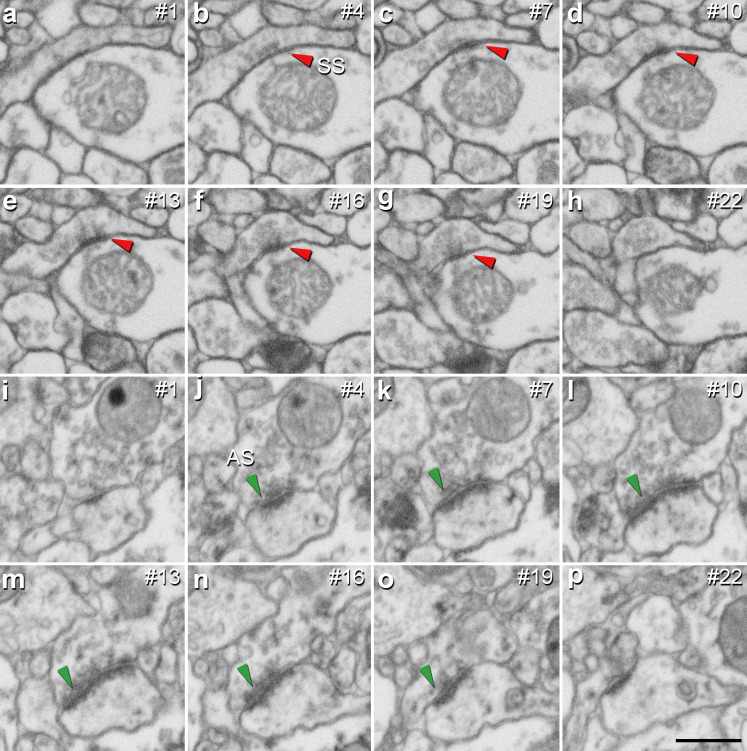
Identification of an asymmetric synapse (AS) and a symmetric synapse (SS) in the neuropil of the human CA1 region.(a−h) Crops from electron microscopy serial sections obtained by FIB/SEM to illustrate an SS (red arrowhead). (i−p) Crops from electron microscopy images following an AS (green arrowhead). The number of the section is indicated in the top right hand corner of each section, with a 60 nm thickness separation between images. Synapse classification was based on the examination of the full sequence of serial material. Scale bar in (p) corresponds to: 500 nm in a−p.